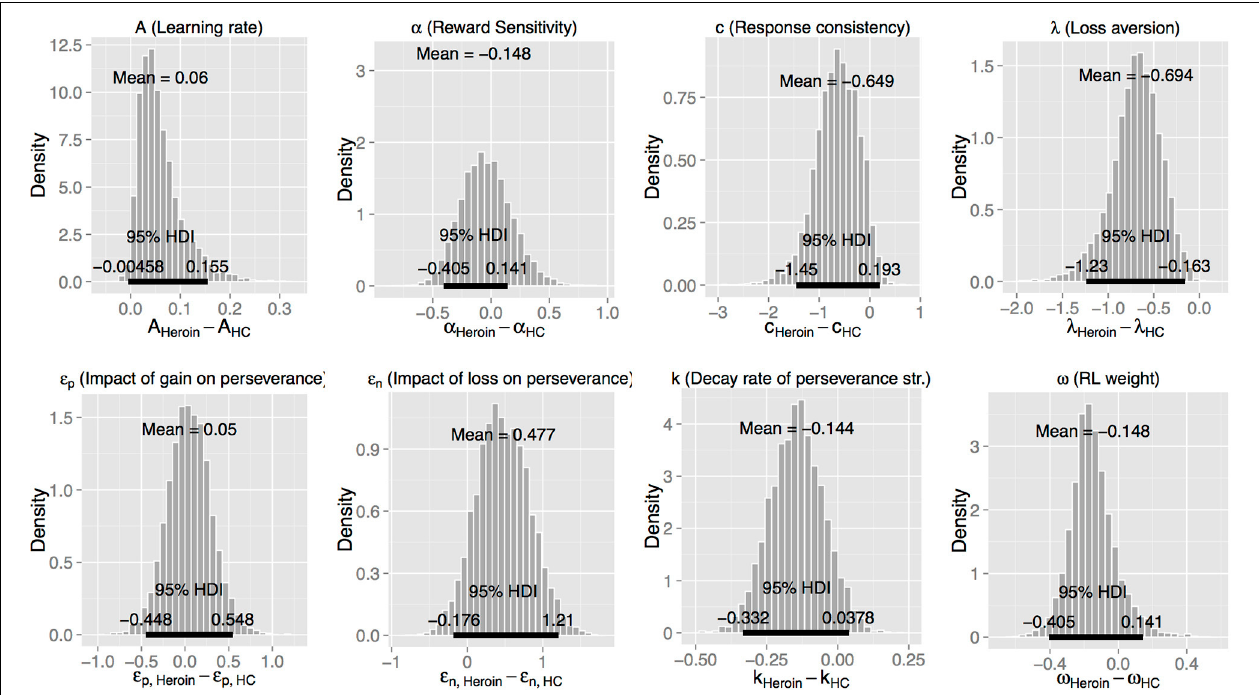
FIGURE 3 | Posterior distributions of differences of group mean parameters between the heroin and the healthy control (HC) groups, with the VPP model. HDI, highest density interval.